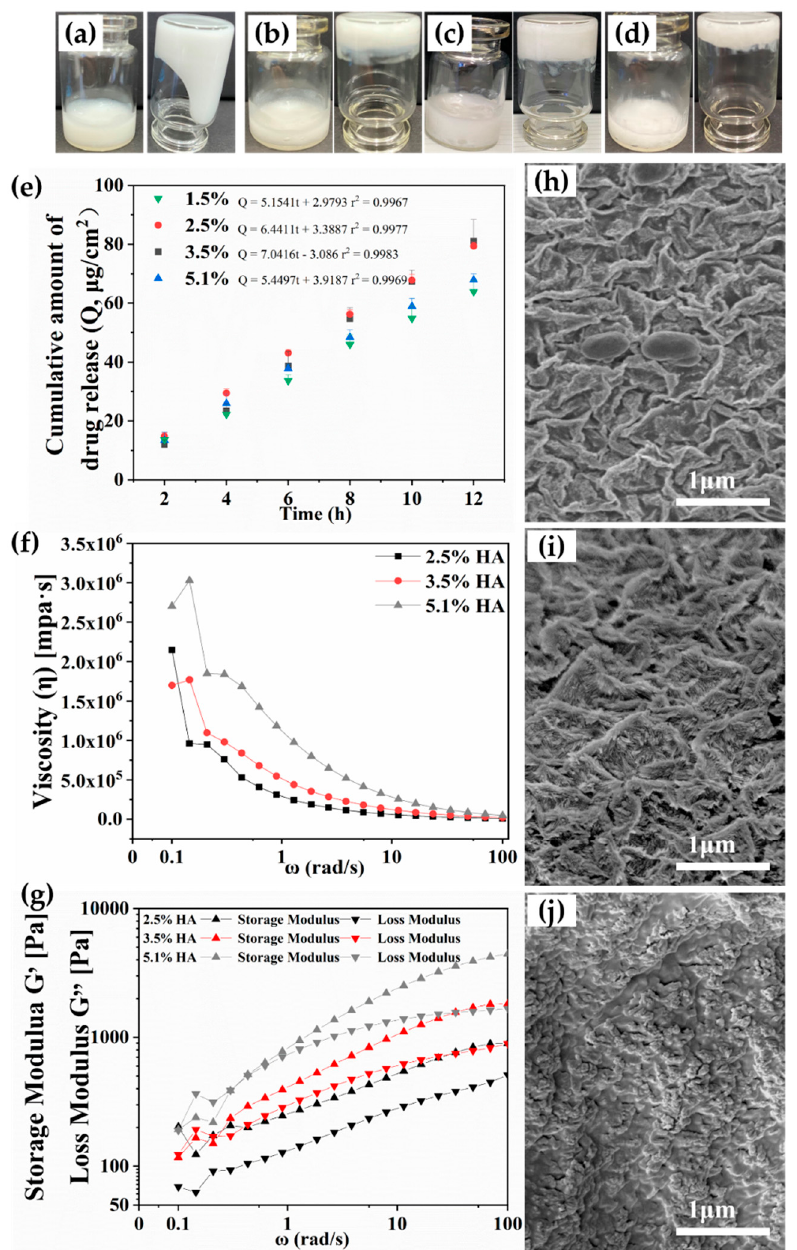
Figure 3. ( a – d ) Photographs of the AA-loaded hydrogels of different content of HA: ( a ) 1.5% HA; ( b ) 2.5% HA; ( c ) 3.5% HA; ( d ) 5.1% HA; ( e ) effects of HA content on the release of AA; ( f ) viscosity of hydrogels with different HA content; ( g ) the storage (G ′ ) and loss modulus (G ″ ) of hydrogels with different HA content; ( h ) SEM of hydrogels of 2.5% HA content; ( i ) SEM of hydrogels of 3.5% HA content; ( j ) SEM of hydrogels of 5.1% HA content. (HA: hyaluronic acid).